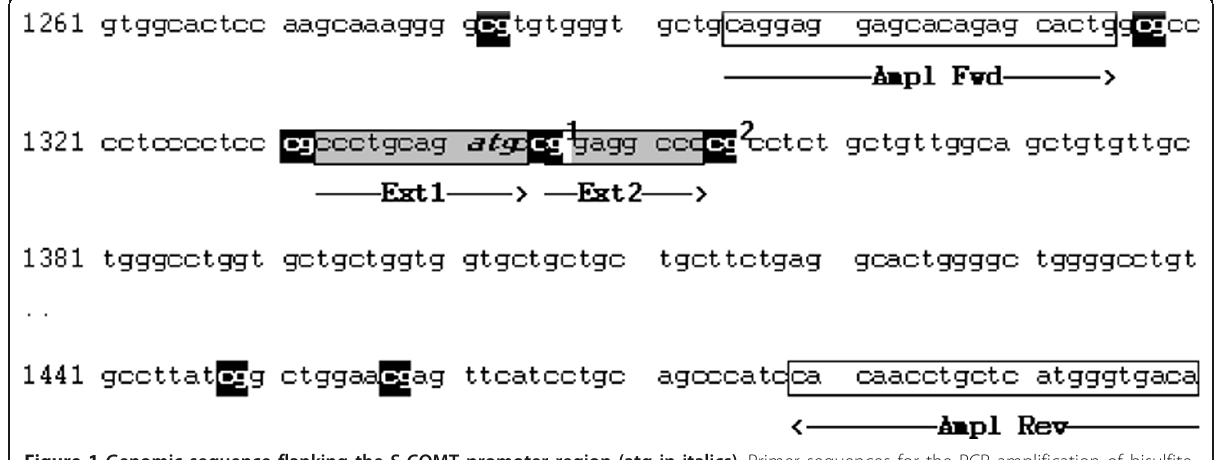
Figure 1 Genomic sequence flanking the S-COMT promoter region (atg in italics) . Primer sequences for the PCR amplification of bisulfite- converted DNA are Ampl Fwd: 5 ’ TAGGAGGAGTATAGAGTATTG 3 ’ and Ampl Rev: 5 ’ TATCACCCATAAACAAATTATA 3 ’ ; Ext1 and Ext2 bordering CG1 and CG2 indicate the complementary extension primer sequences used in the SNuPE analysis.